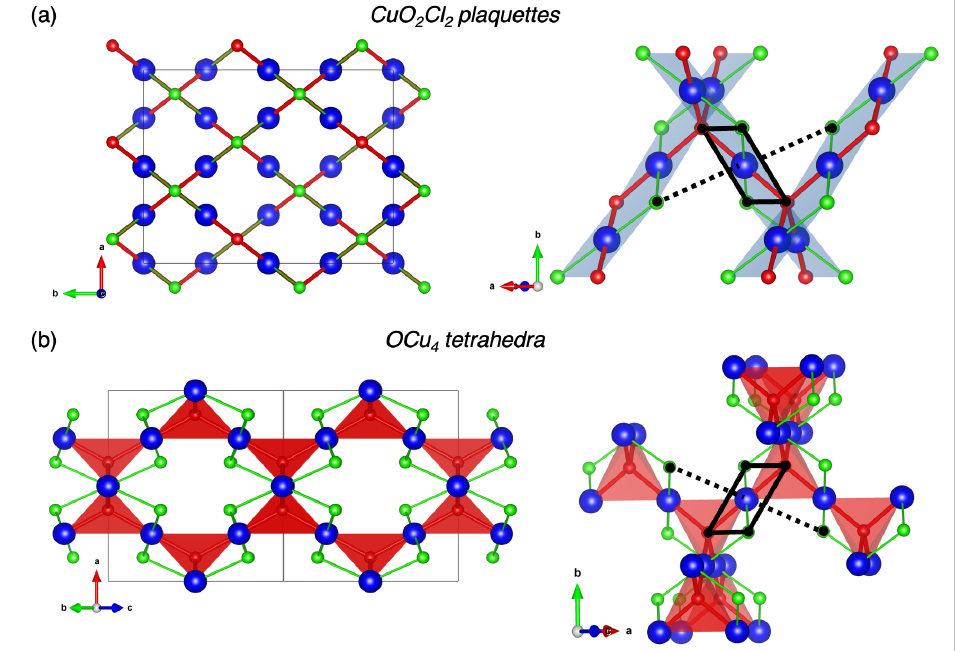
Figure 1. Crystallographic structure of Cu 2 OCl 2 described by ( a ) Cu-centered CuO 2 Cl 2 square planar environments and ( b ) O-centered OCu 4 tetrahedral environments. The blue, red and green spheres represent copper, oxygen and chlorine ions, respectively. Square planar and tetrahedral environments are evidenced in transparent blue and red, respectively. The CuO 2 Cl 4 distorted octahedral environment is highlighted with black